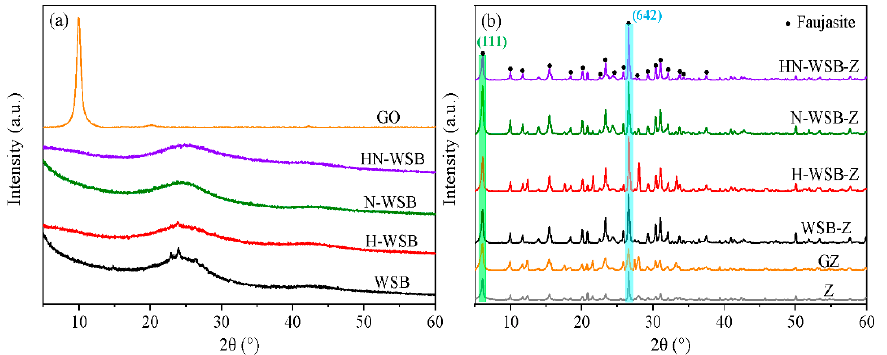
Figure 3. XRD patterns of GO and different biochars ( a ); GO composite FAU, different biochar com- posite FAUs and pure FAU (Z) ( b ).